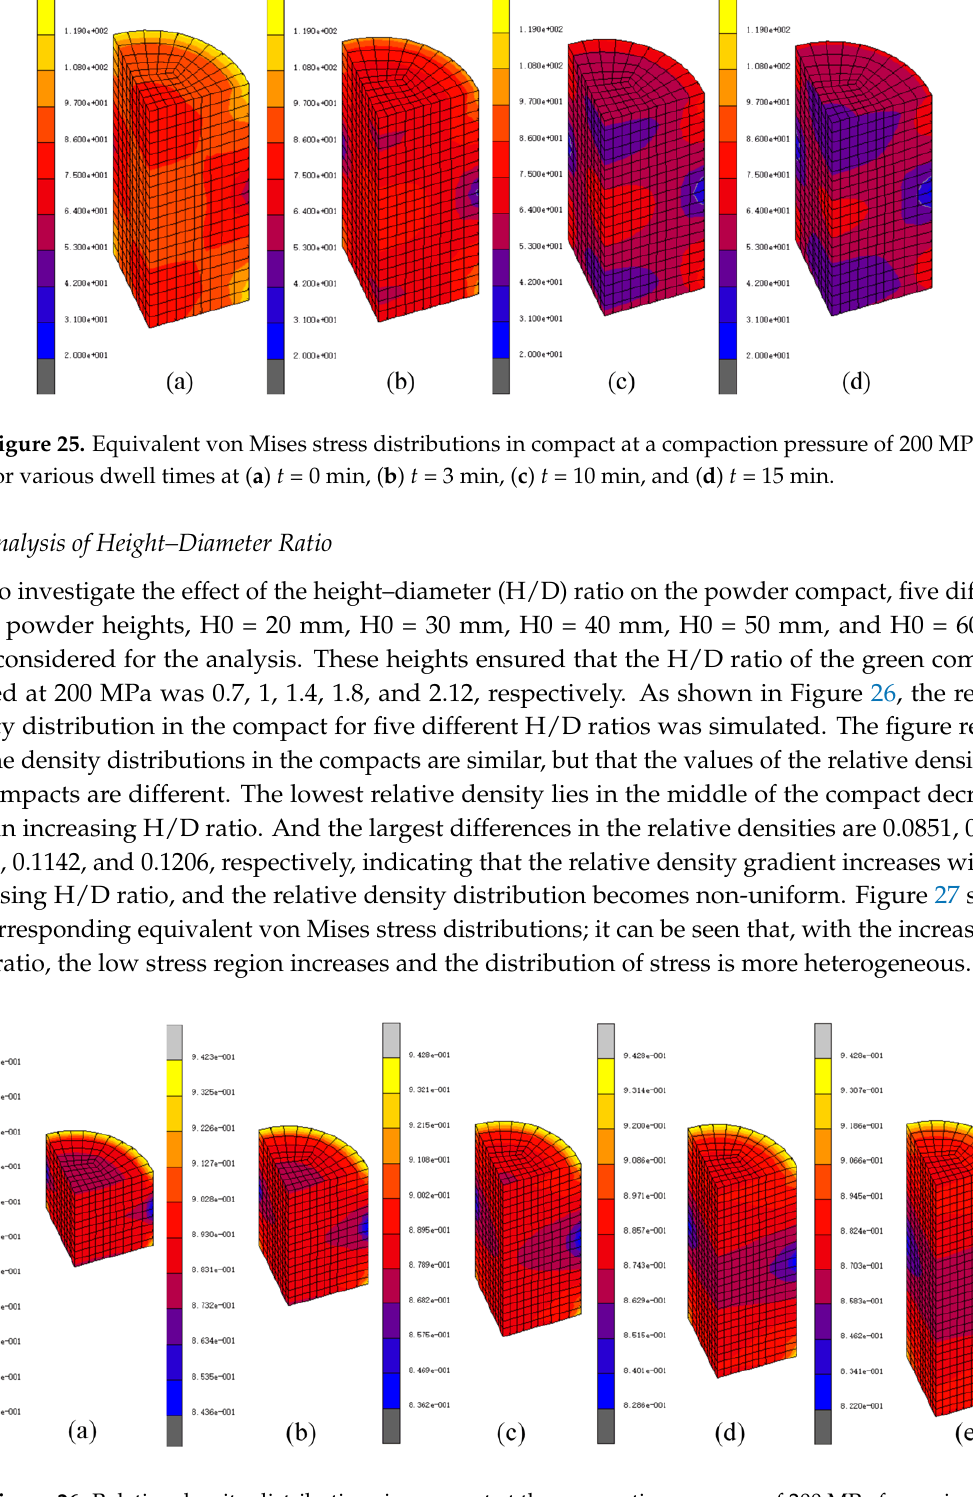
Figure 24. Relative density distributions in compact at compaction pressure of 200 MPa and for various dwell times at ( a ) t = 0 min, ( b ) t = 3 min, ( c ) t = 10 min, and ( d ) t = 15 min.